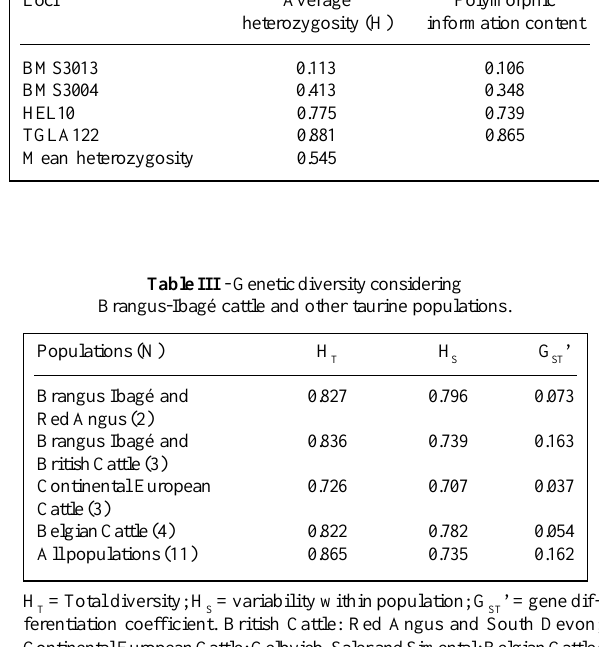
Table II - Genetic variability parameters.